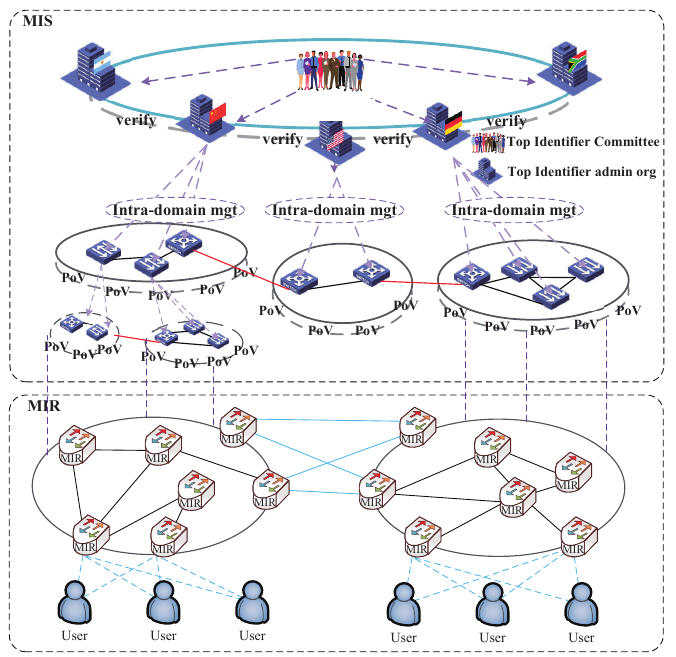
Figure 4. Separation of multi-identifier network management plane and data